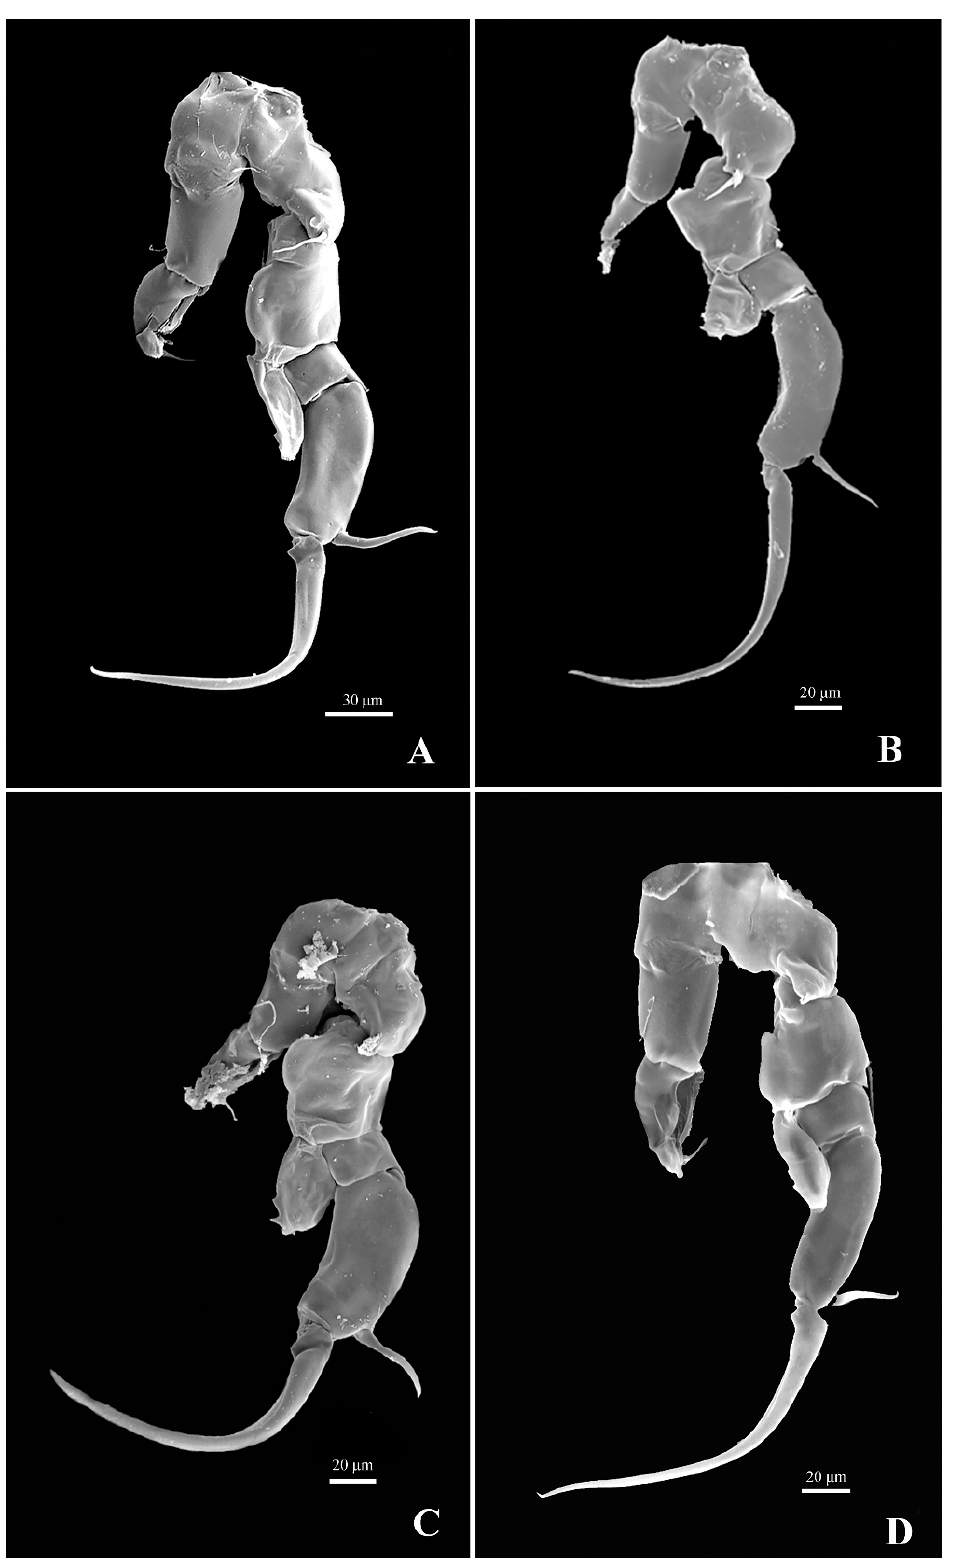
Figure 3. SEM photographs of the male leg 5 (P5) of four species of the genus Eodiaptomus: ( A ) E. sanoamuangae ; ( B ) E. Phuphanensis ; ( C ) E. phuvongi ; and ( D ) E. draconisignivomi.